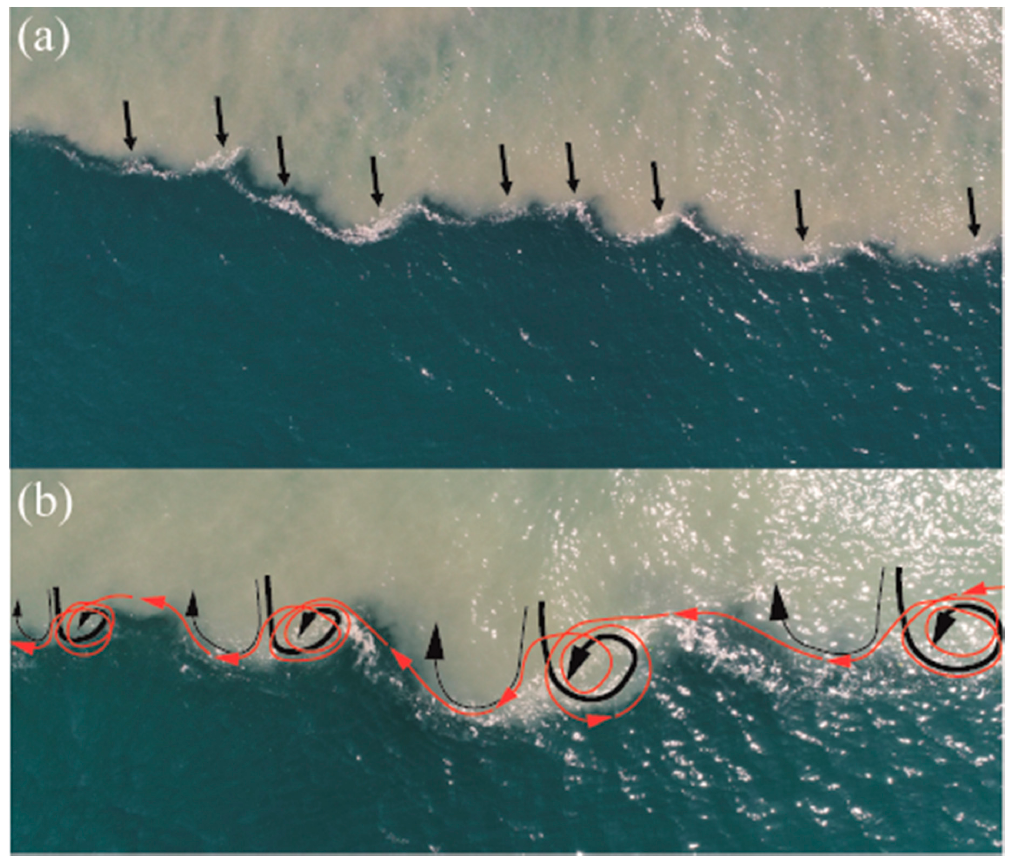
Figure 14. ( a ) aerial image of the undulate border of the Kodor plume on 1 September 2018 and ( b ) the scheme of the reconstructed circulation within the lobes (black lines) and the transport of foam and floating litter along the plume border (red lines) (b). Black arrows in panel ( a ) indicate foam accumulated within cyclonic vortexes in the right parts of the lobes.